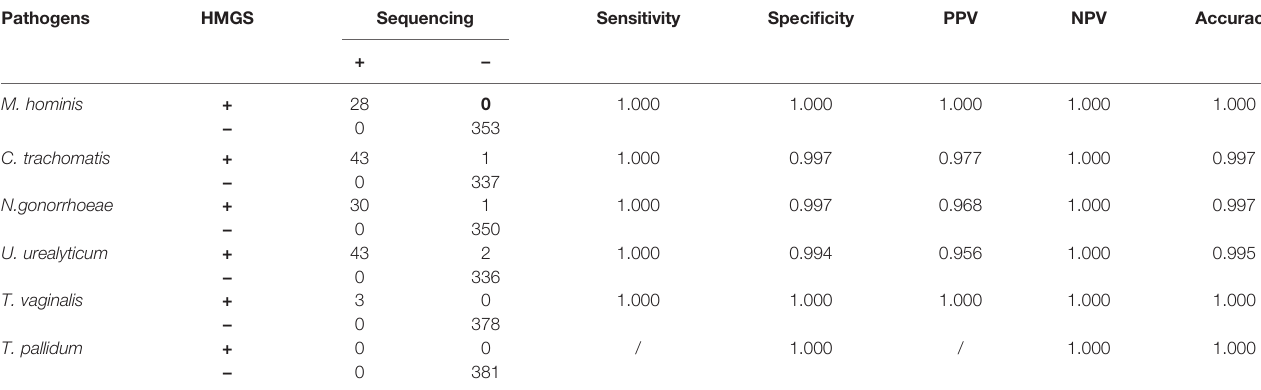
TABLE 5 | STI-HMGS exhibited high levels of accuracy for the detection of six STI pathogens when compared to Sanger sequencing.